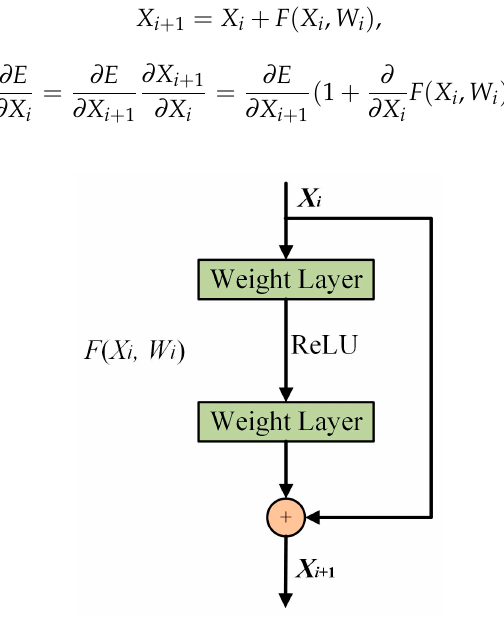
Figure 3. Diagram of the input gate structure of LSTM.